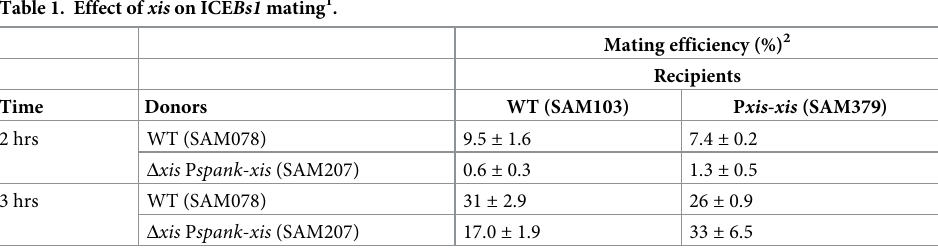
Table 1. Effect of xis on ICE Bs1 mating 1